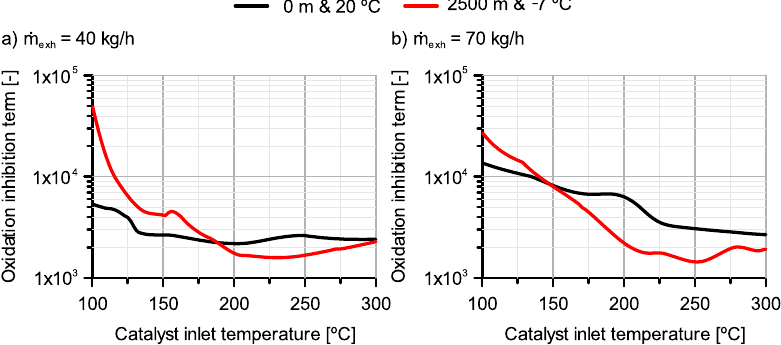
Figure 12. Inhibition term as a function of the DOC inlet temperature and ambient conditions for ( a ) 40 kg/h and ( b ) 70 kg/h in exhaust mass